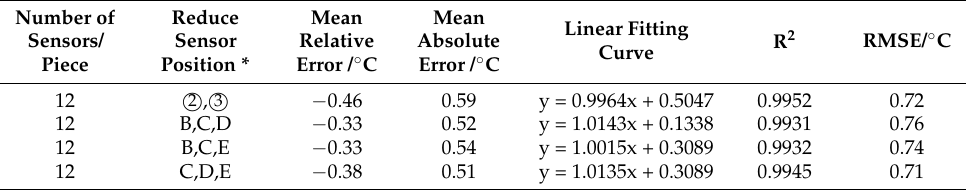
Table 7. Linear correlation analysis results after reducing 12 sensors.